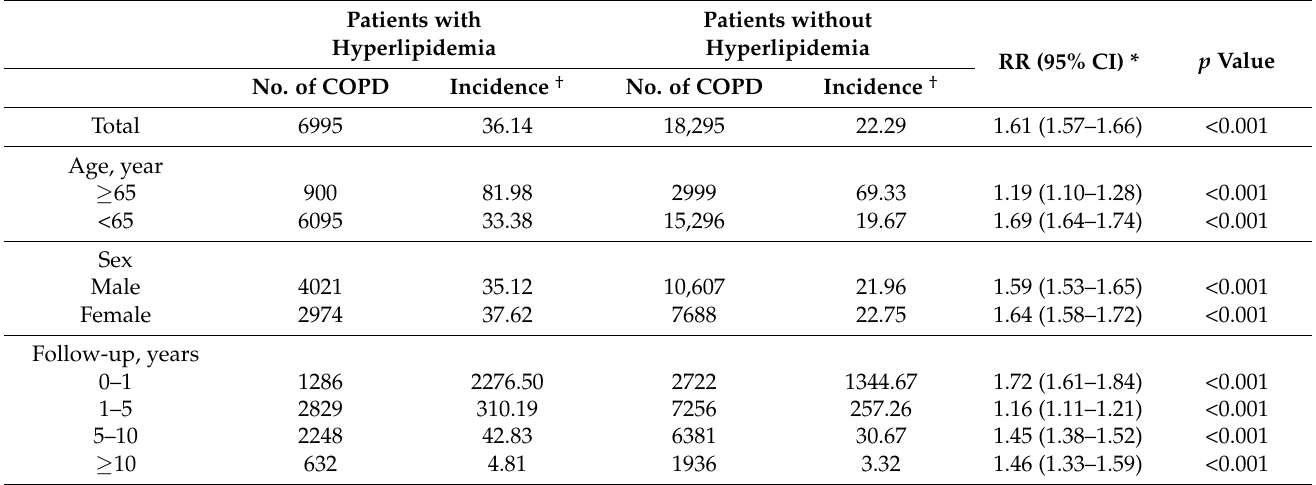
Table 2. Incidence of chronic obstructive pulmonary disease in patients with and without